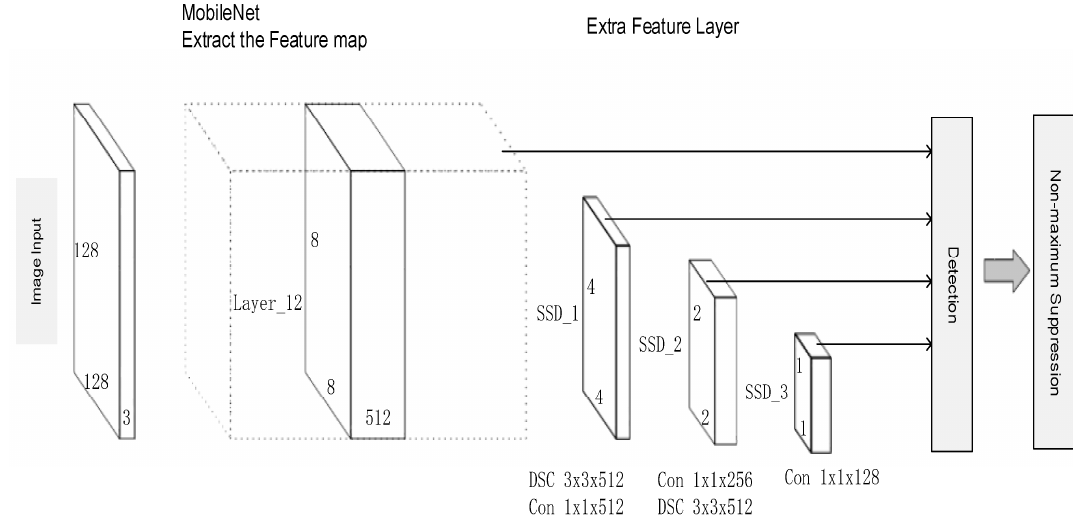
Figure 3. Architecture of the neural network.